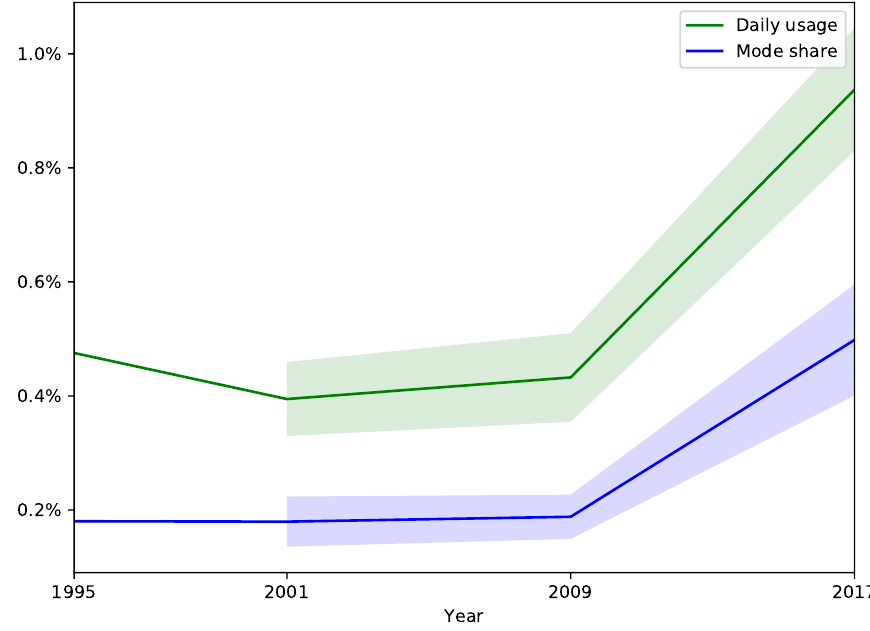
Figure 1. Growth in mode share and daily use of for-hire vehicles (shaded areas represent 95% confidence